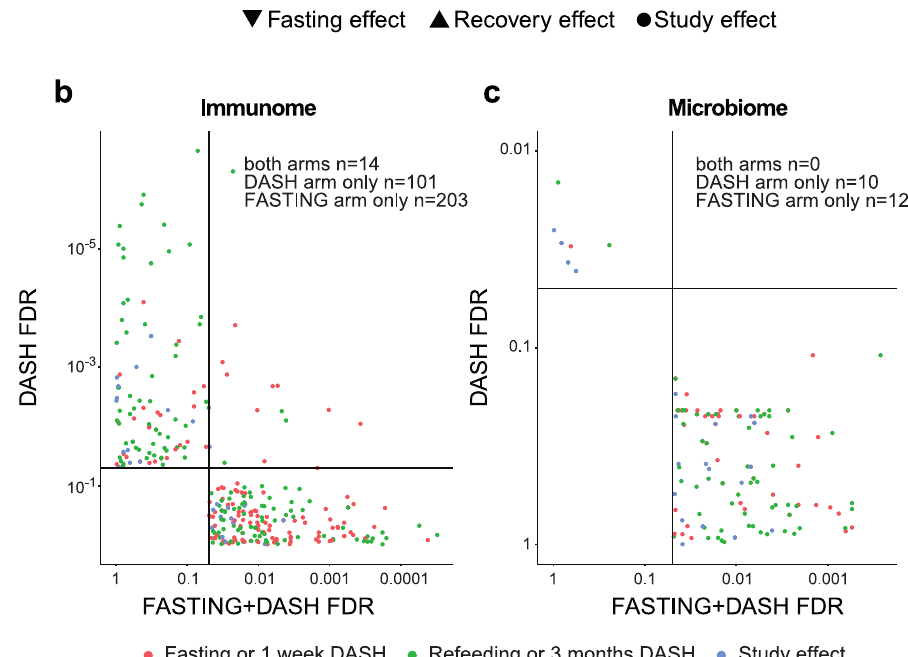
Fig. 3 Fasting and recovery effects are not replicated in an equally powered control cohort, indicating they are intervention-speci fi c. a A majority of host and microbiome effects reported from the fasting + DASH arm are not replicated in DASH-only patients. Comparative effect size plot contrasting features altered signi fi cantly only under fasting + DASH (colored markers, n = 315) with features altered signi fi cantly also under DASH alone, or with absolute effect size greater in DASH alone (gray markers, n = 146). For the former category, color hue shows direction of effect, color intensity scope of effect, and marker shape which time point comparison is shown. Vertical axis shows effect size in DASH only, horizontal effect size in fasting + DASH. Selected features are named for reference. b , c Volcano plots show post-hoc FDR for all features signi fi cantly altered in either arm between any two time points in the fasting arm (horizontal axis), compared to the same sample number DASH arm (vertical axis). Point color shows which time point comparison is plotted. Quadrants (formed by the FDR < 0.05 thresholds) and summary counts highlight features signi fi cantly altered in each dataset for immune cell ( b ) and functional or taxonomic microbiome features ( c ). Only the fasting arm had a signi fi cant effect on the microbiome, and while a smaller fraction of immune features were altered in the DASH-only arm, these were largely not signi fi cant in the fasting arm.